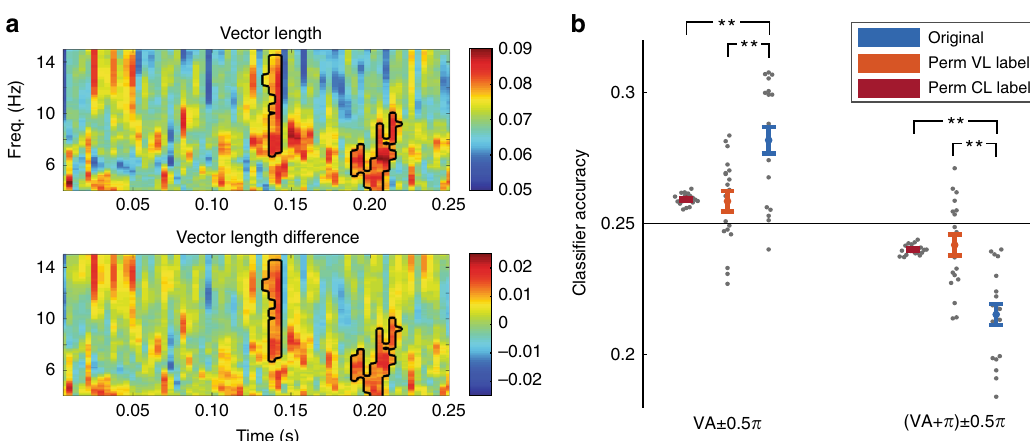
Fig. 1 Phase-dependent decoding of working memory content by a classi fi er trained on the sample item. a Vector length (VL) results shown in time frequency representations. Time zero represents impulse onset (impulse duration was 200 ms). Top fi gure indicates the absolute VL. The bottom fi gure represents the difference between the VL and the random VL based on permutations. The black contour indicates signi fi cant clusters at an alpha of 0.05. b Results of the generalization for the two phase bins (at the vector angle (VA) and VA + π for the frequency and time point of the maximum VL-value). Note that this relates to a post hoc analysis of the main effect of Fig. 1a. Error bars represent the standard error of the mean ( n = 19). The original data is compared against permuted correct/incorrect label at the stage of calculating the VL (perm VL label) or permutation orientation label at the stage of calculating the classi fi cation accuracies (perm CL label). Two-tailed paired t -test, ** p < statistics: 2.49; p = 0.016 and 2.03; p = 0.03 for cluster one and